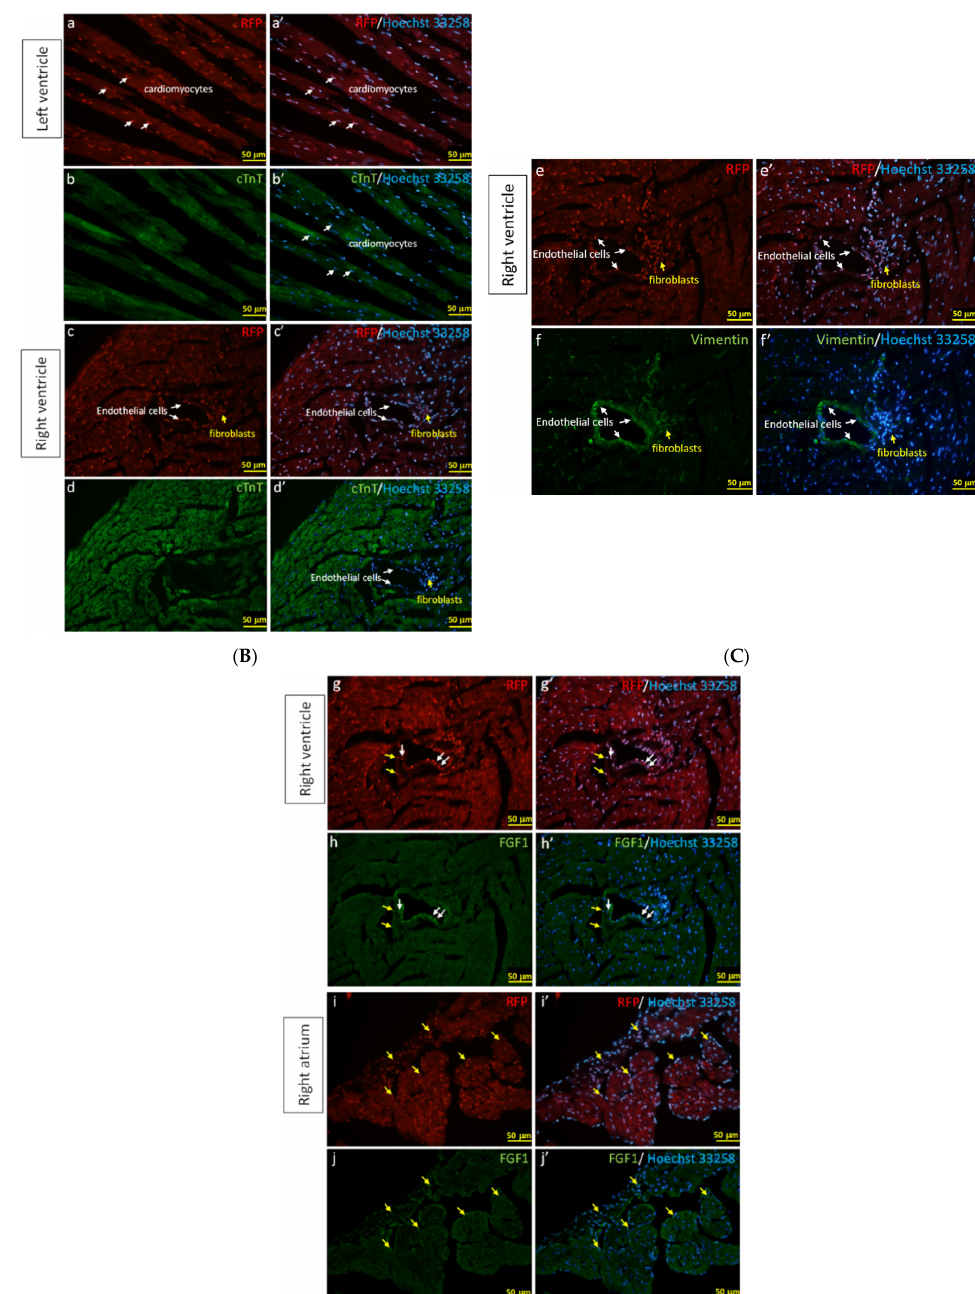
Figure 6. The RFP expression patterns of F1A-CreER T2 transgenic mice correlate with FGF1 IHC staining. ( A1 ) RFP-positive signals were detected in heart tissues of F1A-CreER T2 transgenic mice. Spatial distribution of RFP-positive cells in the heart ( i ). LA: left atrium ( f , g ), LV: left ventricle ( h ), IVS: inter-ventricular septum ( e ), RA: right atrium ( a , b ), RV: right ventricle ( c , d ). AV groove: atrium and ventricle groove. Scale bar, 100 µ m ( a – h ); 2 mm ( i ). ( A2 ) RFP ( a – c ) and Hoechst signals ( a’ – c’ ) in wild type mice. Scale bar, 100 µ m ( a , a’ ); 50 µ m ( b – c’ ). ( B ) RFP-positive cells showed correlated distribution with cTNT-positive cardiomyocytes in the left ( a – b’ ) and right ventricles ( c – d’ ). ( C ) RFP-positive cells showed correlated distribution with vimentin-positive endothelial cells and fibroblasts in the right ventricles ( e – f’ ). ( D ) RFP-positive cells showed correlated distribution with FGF1-positive endothelial cells, fibroblasts and cardiomyocytes in the right ventricles ( g – j’ ). Scale bar, 50 µ